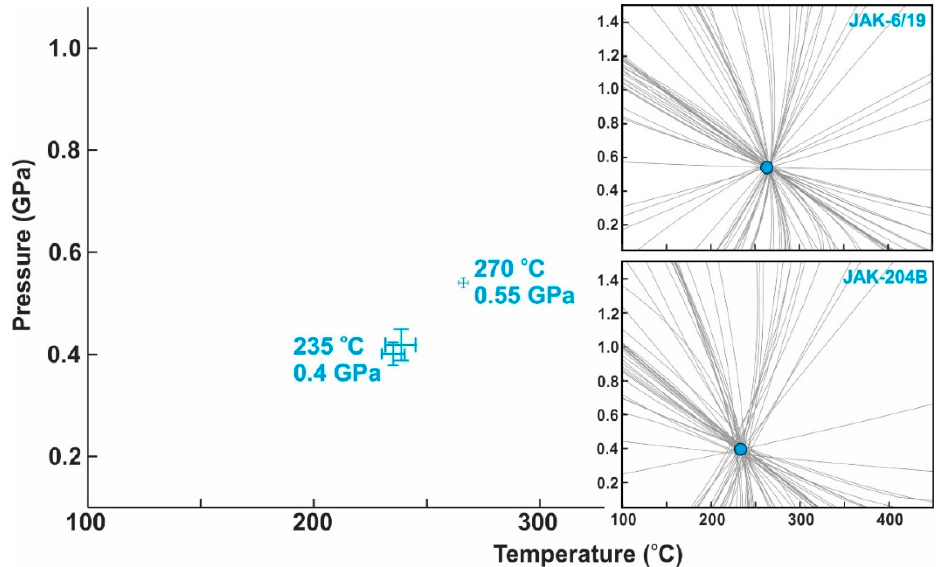
Figure 29. P–T diagrams showing univariant curves and points intersecting Chl–Ph pairs at equilibrium P–T conditions of 270 ° C at 0.55 GPa (s. JAK-6/19) and 235 ° C at 0.4 GPa (s. JAK-204B). Jaklovce Unit diagrams were created by the MATLAB script provided by [43]. Crosses represent Chl–Ph pairs equilibrium tolerance. Table 11. Jaklovce Unit rock P–T estimates by combined geothermobarometry.